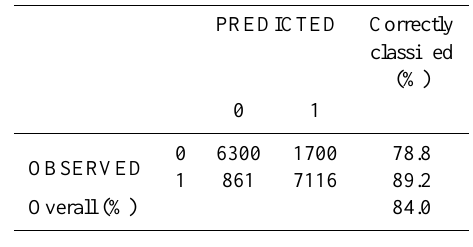
Table 2. Confusion matrix with validation sample constituted by the 50% of the overall sample (0: absence of phenomenon; 1: pres- ence of phenomenon, cut-off value: 0.5).